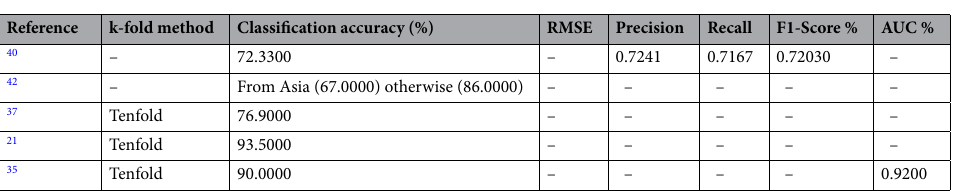
Table 8. Summary of performance metrics from previous